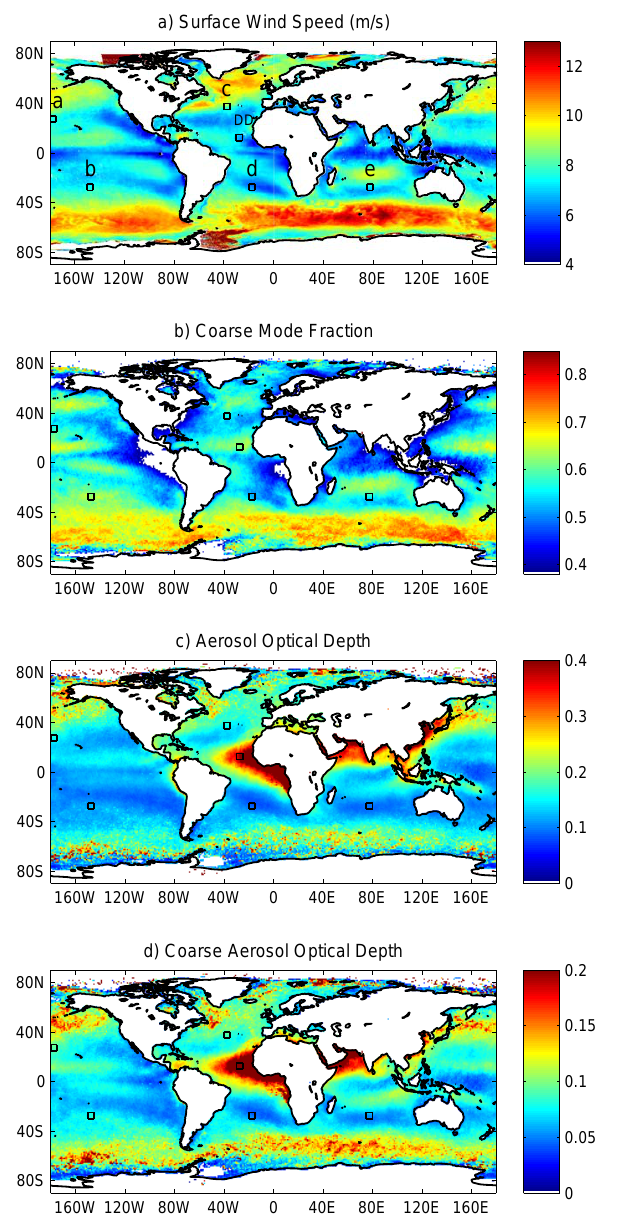
Fig. 1. 2004 annual mean distribution of (a) W ; (b) f c ; (c) τ ; (d) τ c . The black boxes and the letters in panel a indicate regions used in the analysis presented in the following figures.